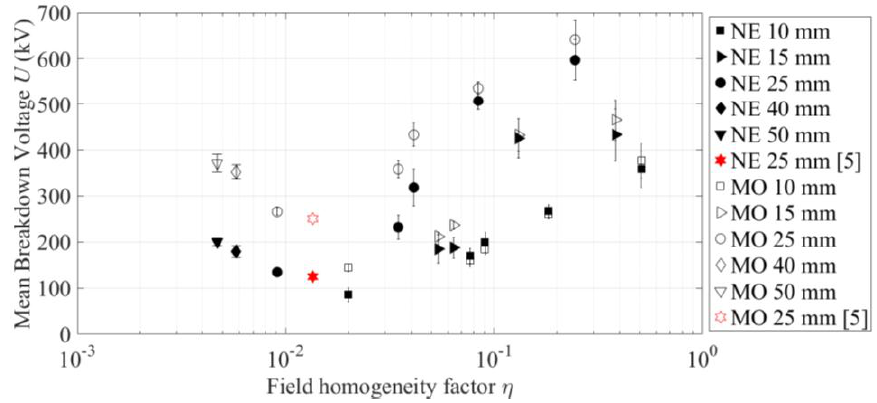
Figure 10. Comparison: mean breakdown voltages of present investigation vs. data from study [5] for natural ester liquid and mineral oil.